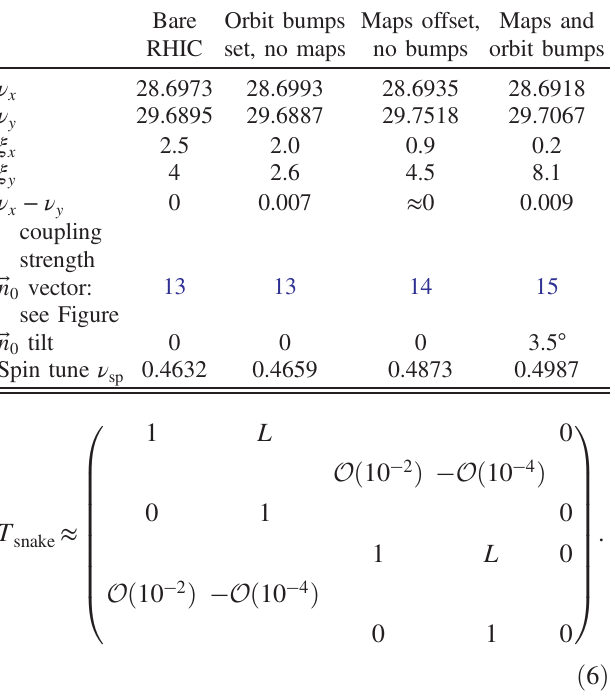
TABLE II. RHIC and spin closed orbit parameters, G γ ¼ 45 . 5 . Column 1: bare RHIC ring, no field maps, flat orbit; column 2: vertical orbit bumps in snake region are set, no field maps; column 3: the orbit is flat, except over the 10.472 m helical path across snake field maps which are (cid:2) 0 . 8 cm offset; column 4: normal polarized proton operation: snake field maps and local vertical closed orbit bumps are in place in the RHIC lattice model.